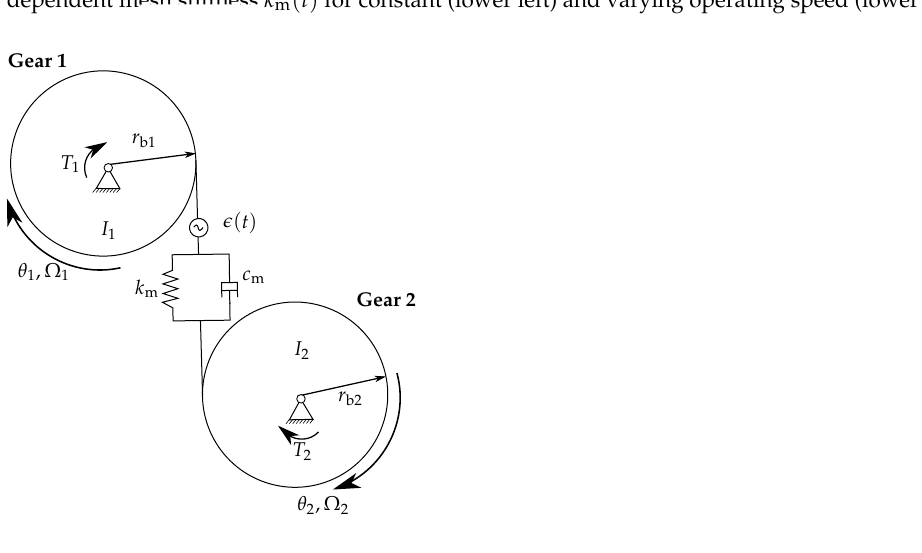
Figure 8. Gear dynamic model consisting of two rigid discs, representing the moments of inertia, connected at the corresponding base circle radii r b1 and r b2 by a spring element representing the mesh stiffness k m ( t ) , and a viscous damper representing the mesh damping with the damping coefficient c m ( t )